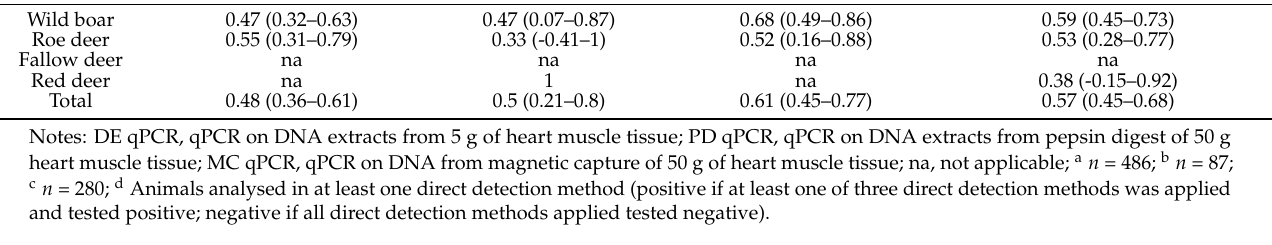
Table 3. Concordance between DE qPCR, PD qPCR, MC qPCR and ELISA measured in kappa values ( κ (95% CI)). Game